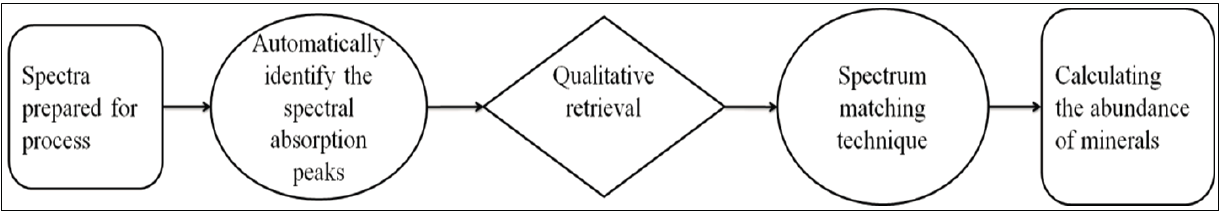
Figure 9. Flowchart of mineral spectrum processing for quantitative analysis.